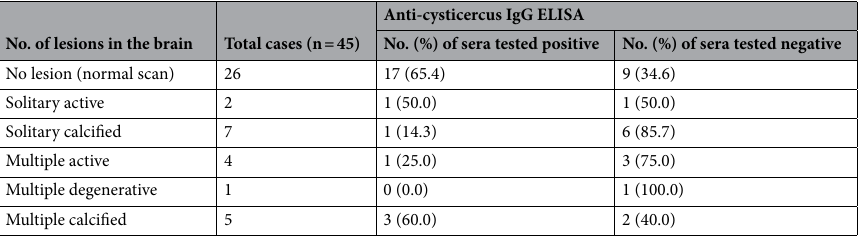
Table 3. Anti-cysticercus antibodies in sera from patients with respect to number of lesions in the brain.